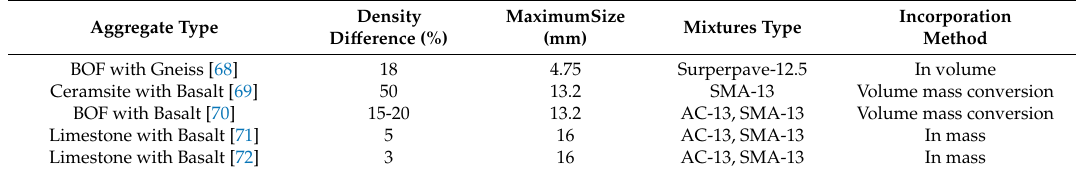
Table 7. The incorporation methods of aggregate in asphalt mixture